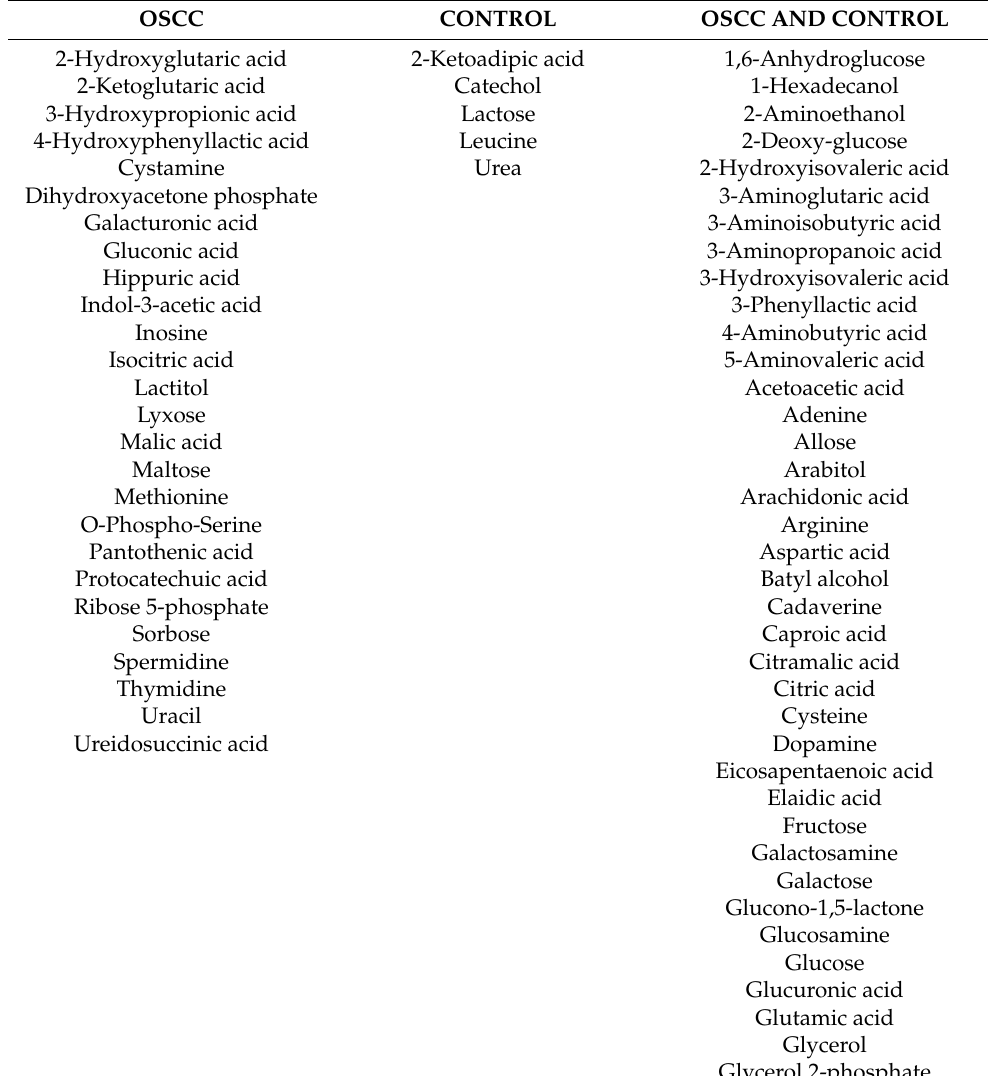
Table 3. Exclusive and shared salivary metabolites for OSCC and control